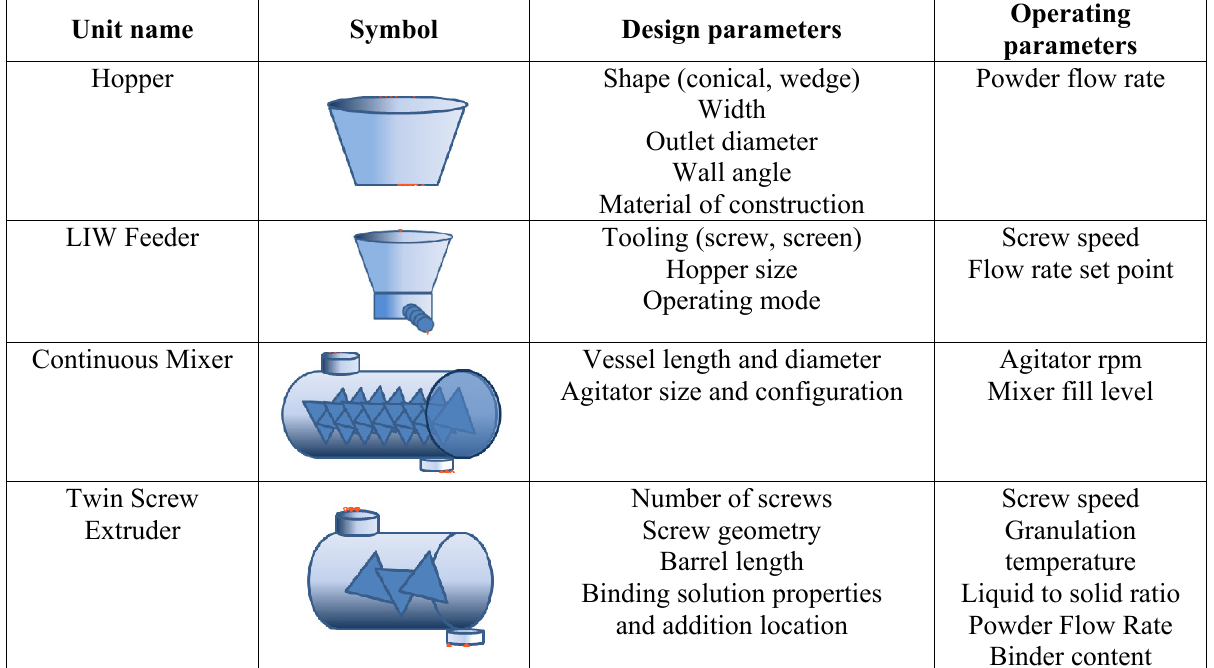
Table 1. Processing equipment for continuous tablet manufacturing including the adjustable design and operating